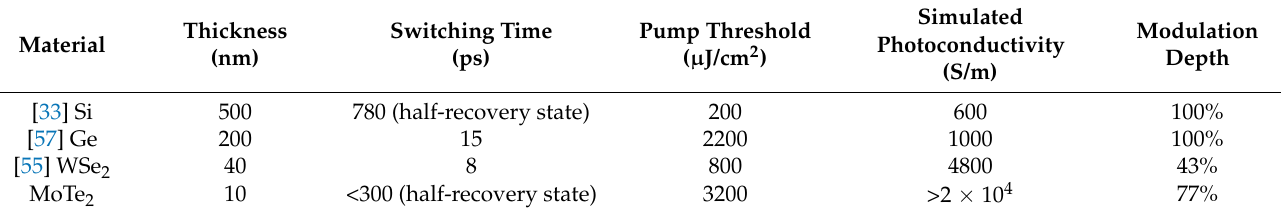
Table 1. Comparison of the ultrafast all ‐ optical tuning metasurfaces.